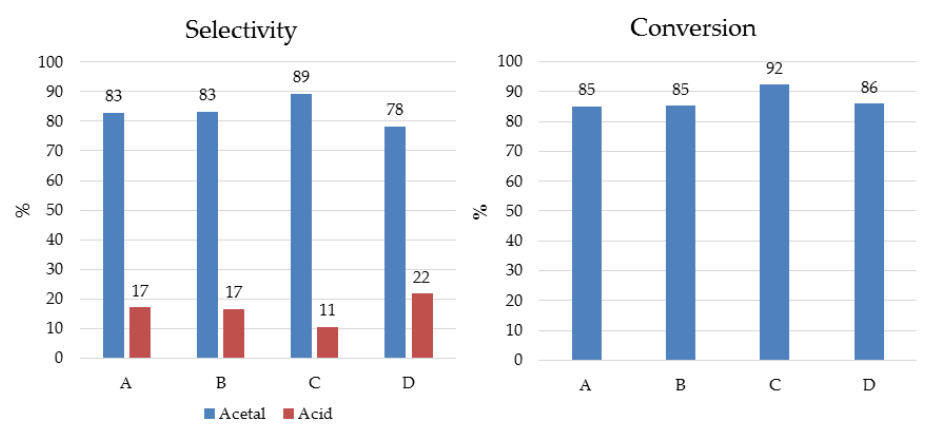
Figure 4. Schematic results for the reusability test with CNS-Cu.